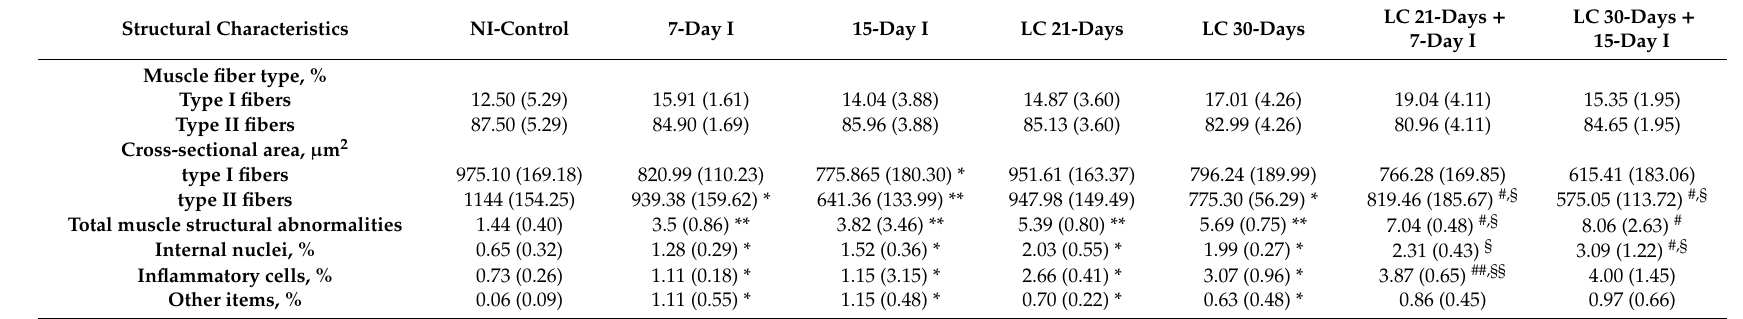
Table 2. Structural characteristics of the gastrocnemius in all the experimental groups of